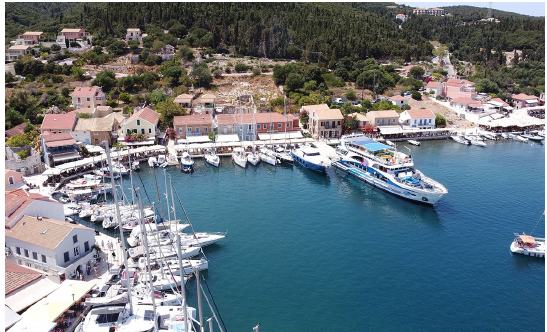
Figure 1 . Fiskardo Port, drone photo, northern view.